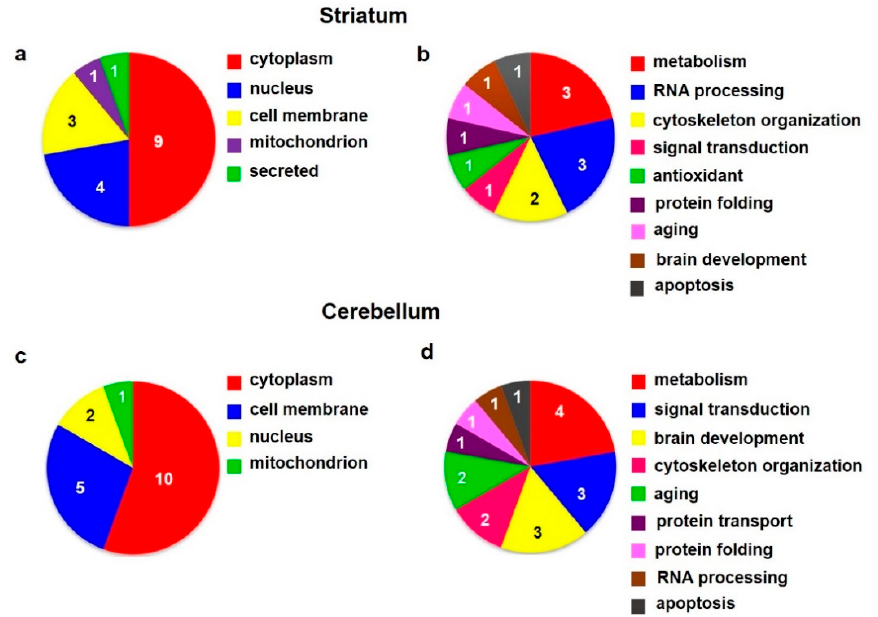
Figure 7. Subcellular localization ( a , c ) and function ( b , d ) of altered proteins identified in the rat striatum ( upper panels ) and cerebellum ( lower panels ) isolated from animals after 6 months of morphine withdrawal; according to the current annotations (https://www.uniprot.org, accessed on 20 October 2021) in the UniProt database.